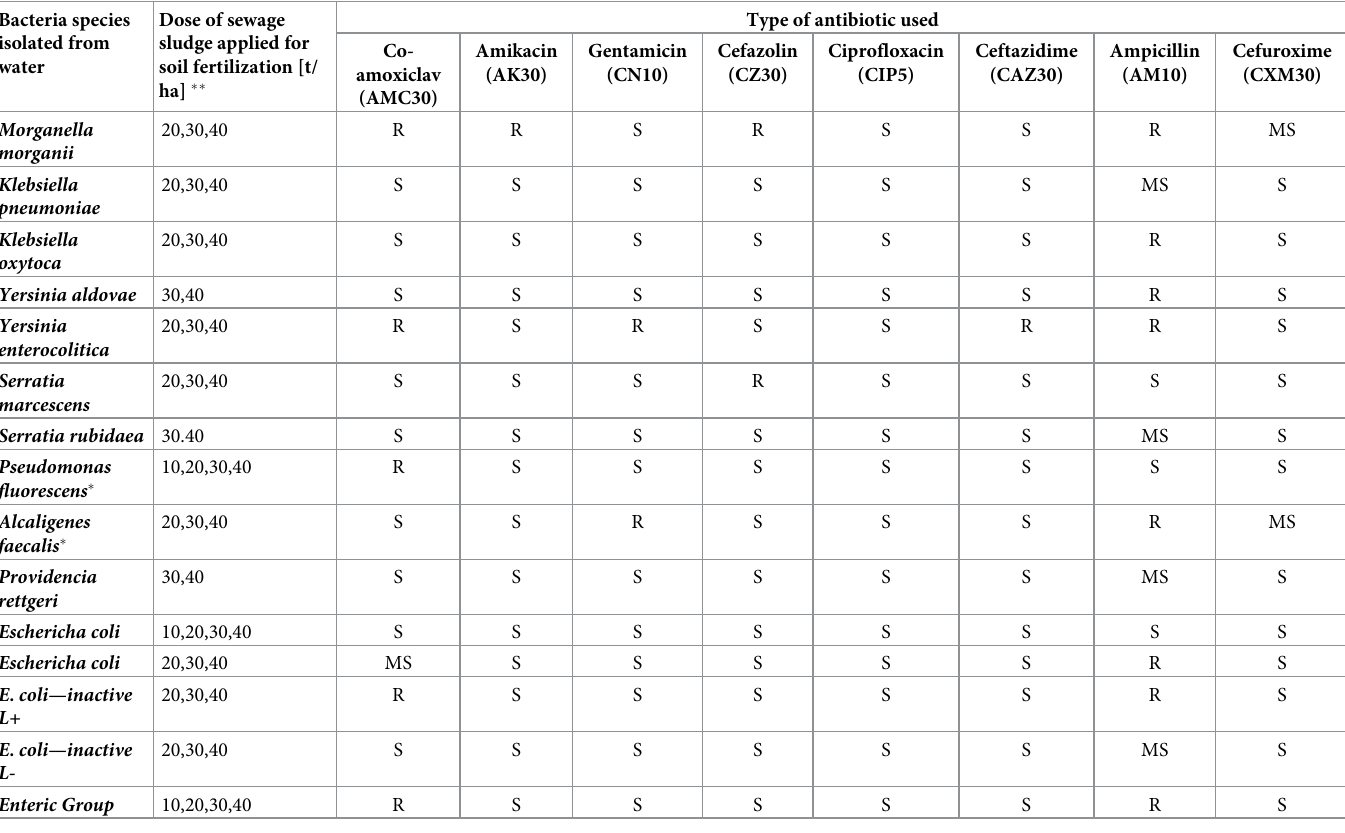
Symbols used for susceptibility of bacteria to antibiotics: S—susceptible, MS—medium susceptible, R—resistant. � species that are typically saprophytic in the environment.